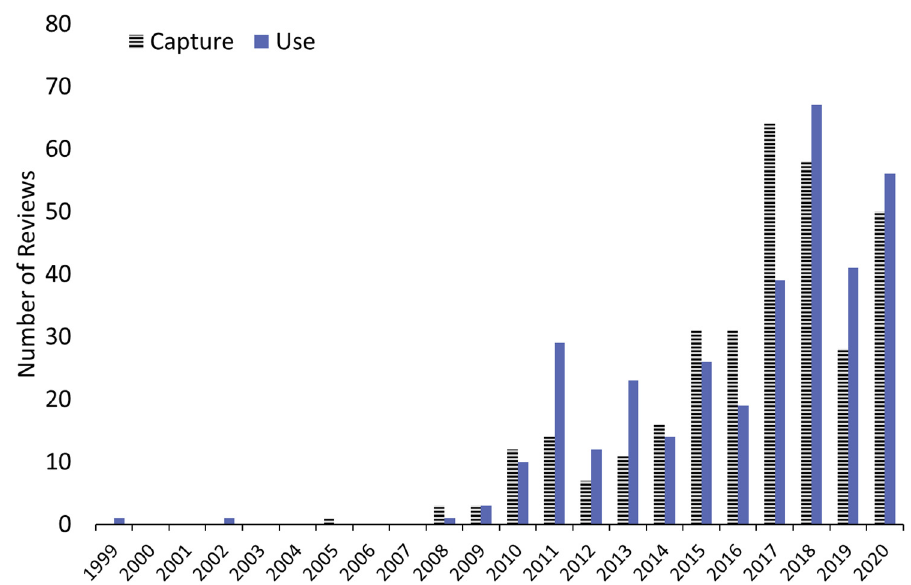
Figure 7. Distribution of published review papers regarding carbon capture and use, related to the main scope of the present work.